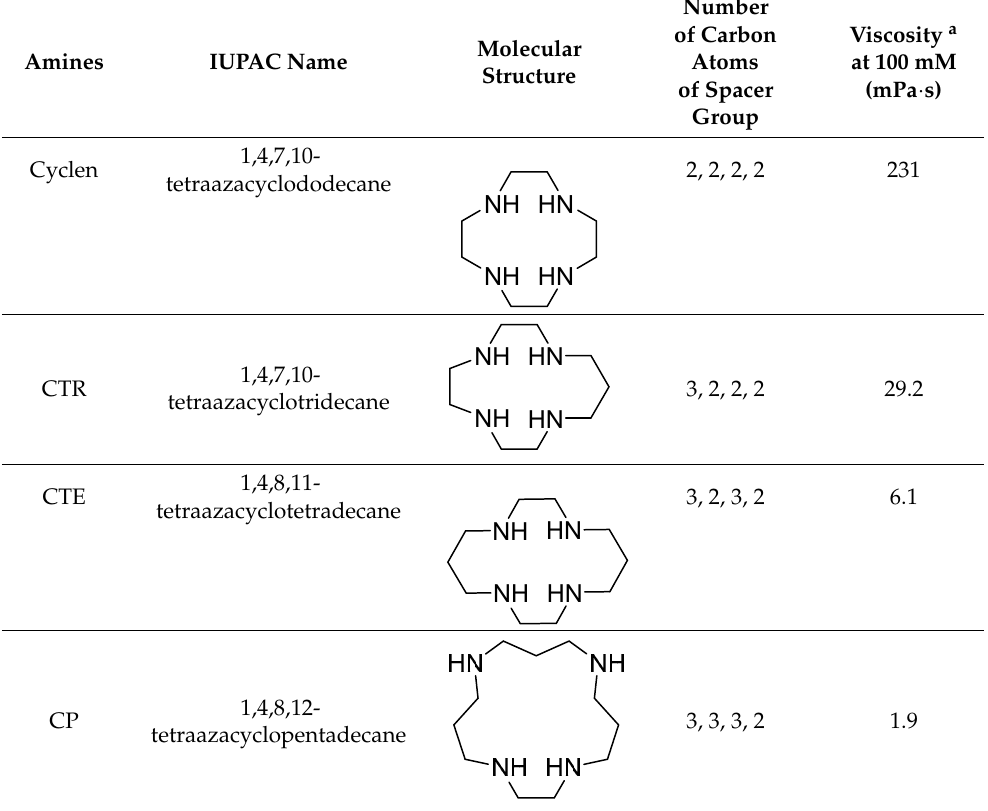
Table 1. Comparison of the viscosity of SA mixed with different amines (molar ratio, 4:1). Amines